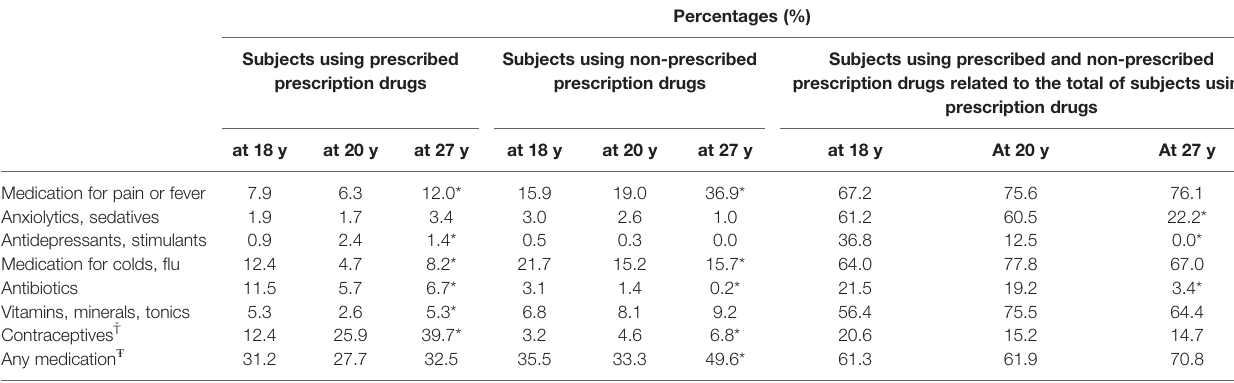
TABLE 2 | Proportions of subjects using prescription drugs during the previous 15 days. Percentages (%) Subjects using prescribed Subjects using non-prescribed prescription drugs prescription